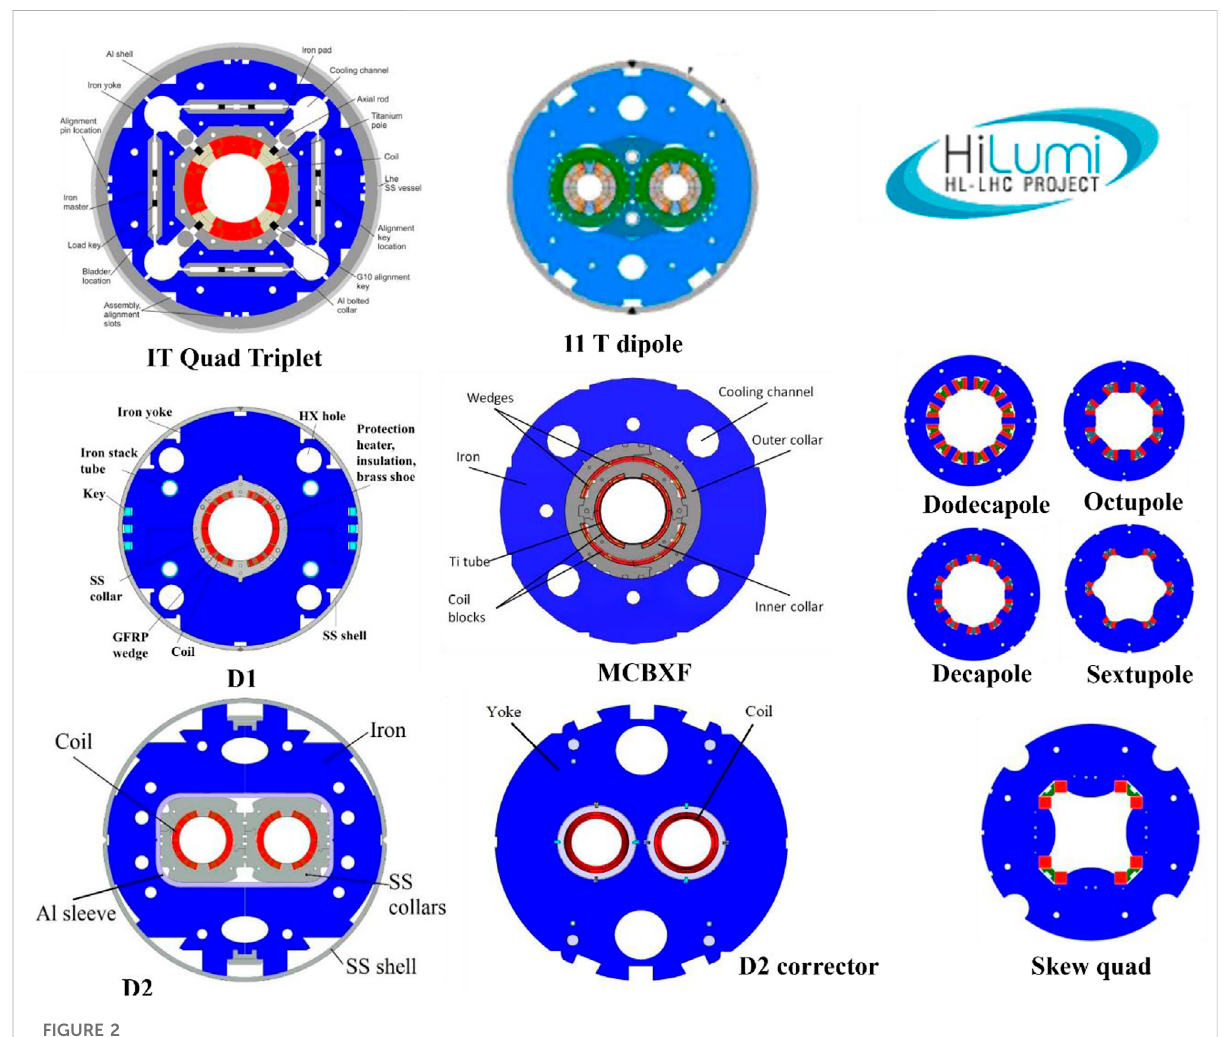
FIGURE 2 The cross section of the various magnets developed for High Luminosity LHC.